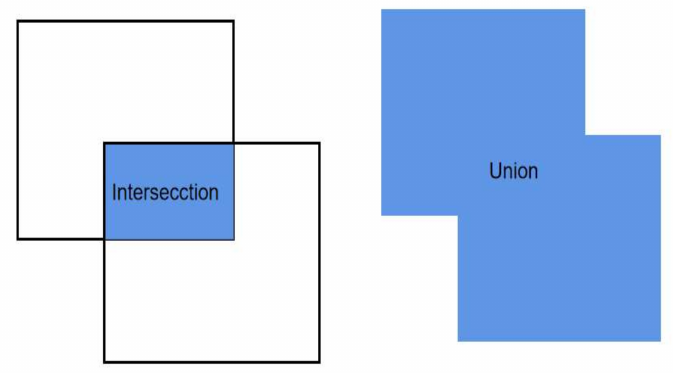
Figure 3. Schematic diagram of the intersection and merging of two regions. A trajectory extraction method is used to create a tracker for each object (vehicle in a specific area of the video). The position of the vehicle predicted by each tracker in the next frame and the result of the vehicle detection algorithm in the next frame are calculated separately. When the intersection ratio is greater than a set threshold, the bounding box generated by the detection algorithm can be assigned to the trajectory represented by the corresponding tracker. After the vehicle detection result is processed by the trajectory extraction algorithm, the trajectory information of each vehicle travelling at the road intersection during that time period can be obtained. The specific algorithm steps are given below and Figure 4 demonstrates the process of the vehicle trajectory